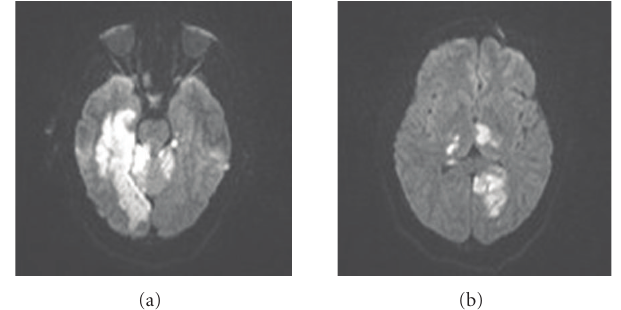
Figure 1: Di ff usion weighted MRI demonstrates several confluent areas of restricted di ff usion, consistent with infarction, confined to the bilateral posterior circulation (a,b). This was confirmed on apparent di ff usion coe ffi cient maps (not shown). No restricted di ff usion was present in the anterior circulation (not shown).